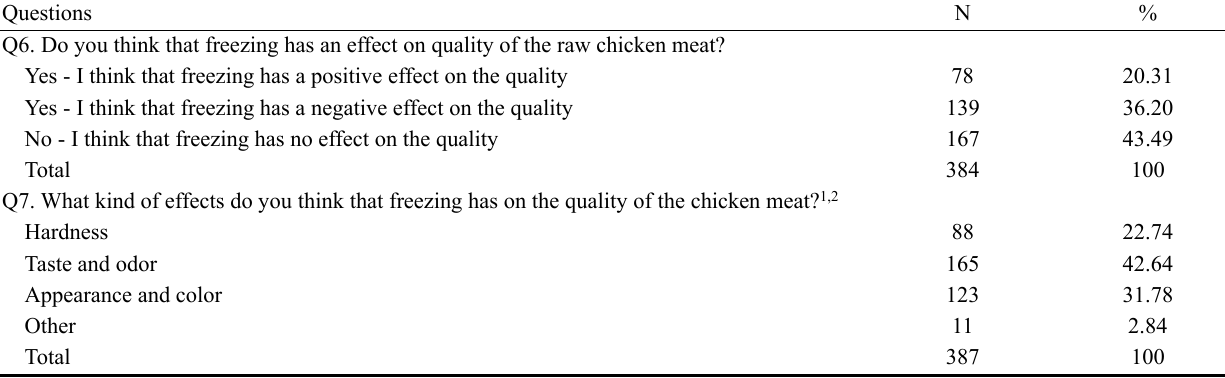
Table 3. Questions related to consumers’ opinion about the effects of the freezing on the quality of the chicken meat